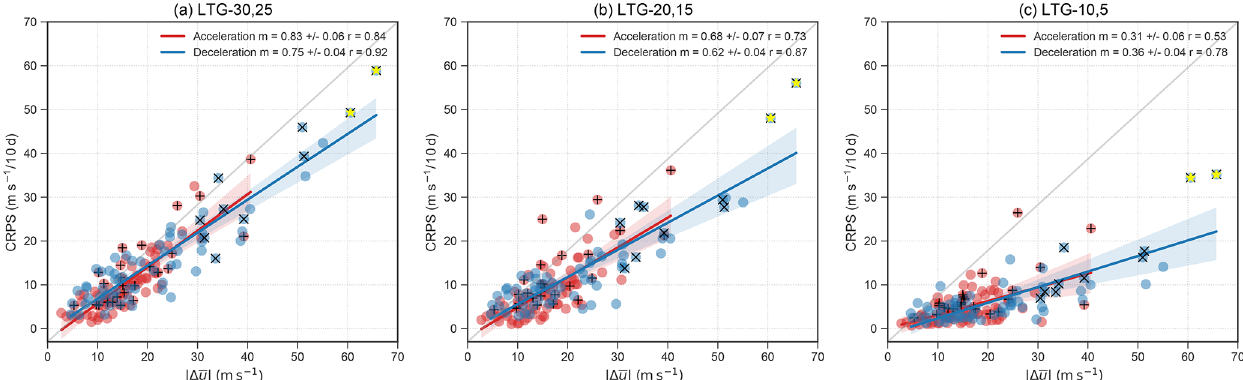
Figure 3. CRPS of event magnitude ( (cid:49)u ) for the identified wind acceleration (red) and deceleration (blue) events plotted against their absolute event magnitude ( | (cid:49)u | ) from reanalysis for different LTGs. The absolute value of event magnitude ( | (cid:49)u | ) is used for a better comparison between acceleration and deceleration events. Linear regression lines are fitted to each of the LTGs, and m indicates the slope, including the standard error of the fit. Pearson correlation coefficients ( r ) are indicated in the legend for acceleration and deceleration events, and r is statistically significant at 95% for all panels. The shaded region shows the 95% confidence interval of the linear fit. Pluses (“ + ”) indicate events that correspond to strong vortex events, and crosses (“ × ”) correspond to SSW events. Yellow asterisks (“ ∗ ”) denote the 2009 and 2018 split SSW events.